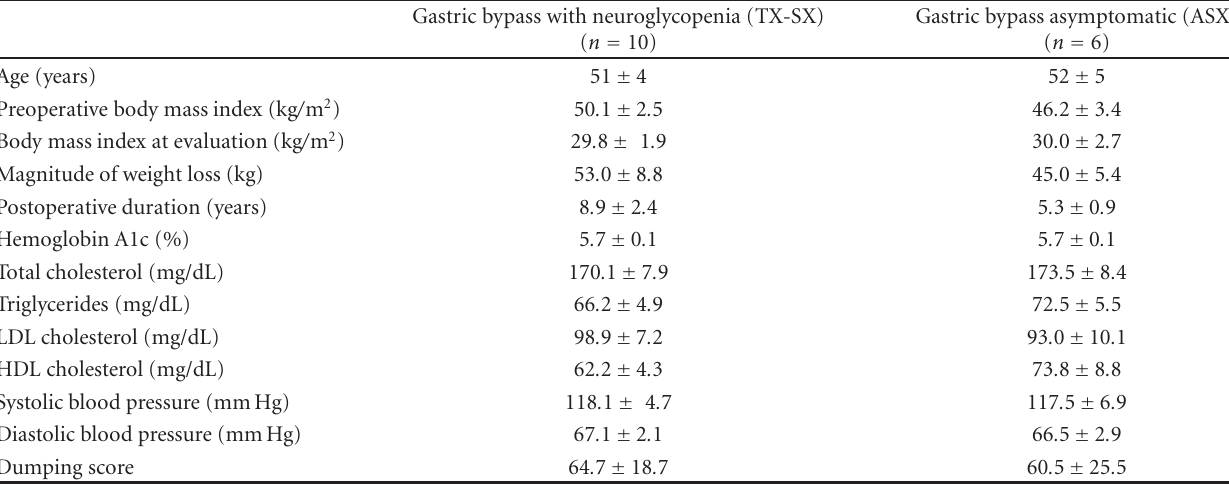
Table 1: Characteristics of study